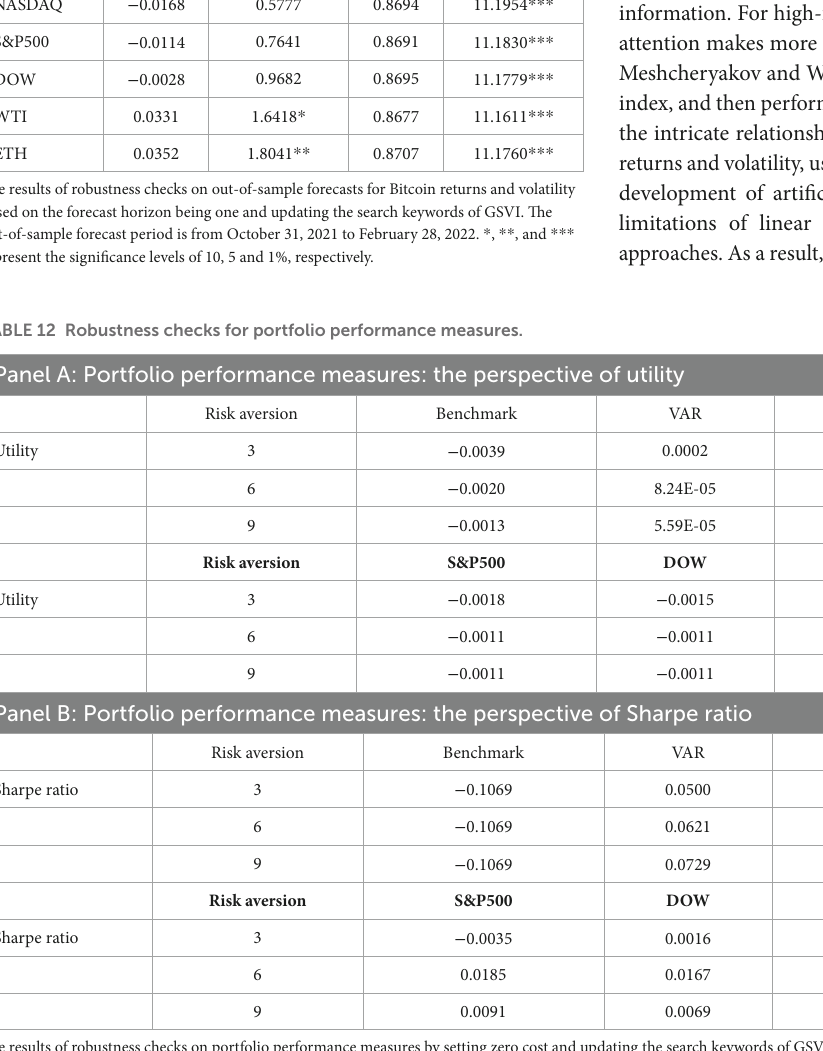
TABLE 11 Robustness checks for out-of-sample forecasts.